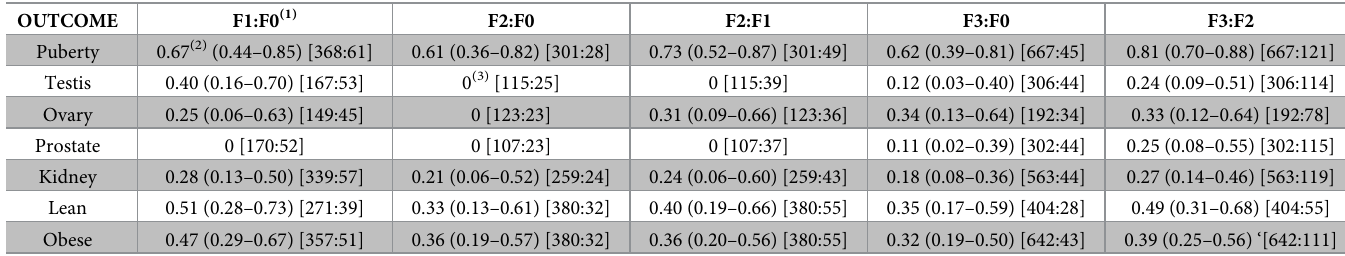
Table 1. Litter effects (95% CI) [sample sizes] by